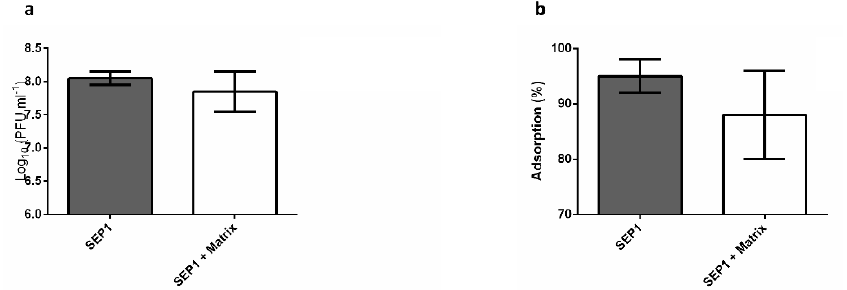
Figure 4. E ff ect of biofilm matrix on SEP1 e ffi ciency. ( a ) Phage infectivity in a biofilm matrix suspension after 2 h of incubation at 37 ◦ C. Data was assessed by PFU counting and the values represent the mean plus and minus of three independent experiments performed in triplicate; ( b ) phage adsorption in the presence of biofilm matrix. Data was assessed by PFU counting and the values represent the mean plus and minus of two independent experiments performed in